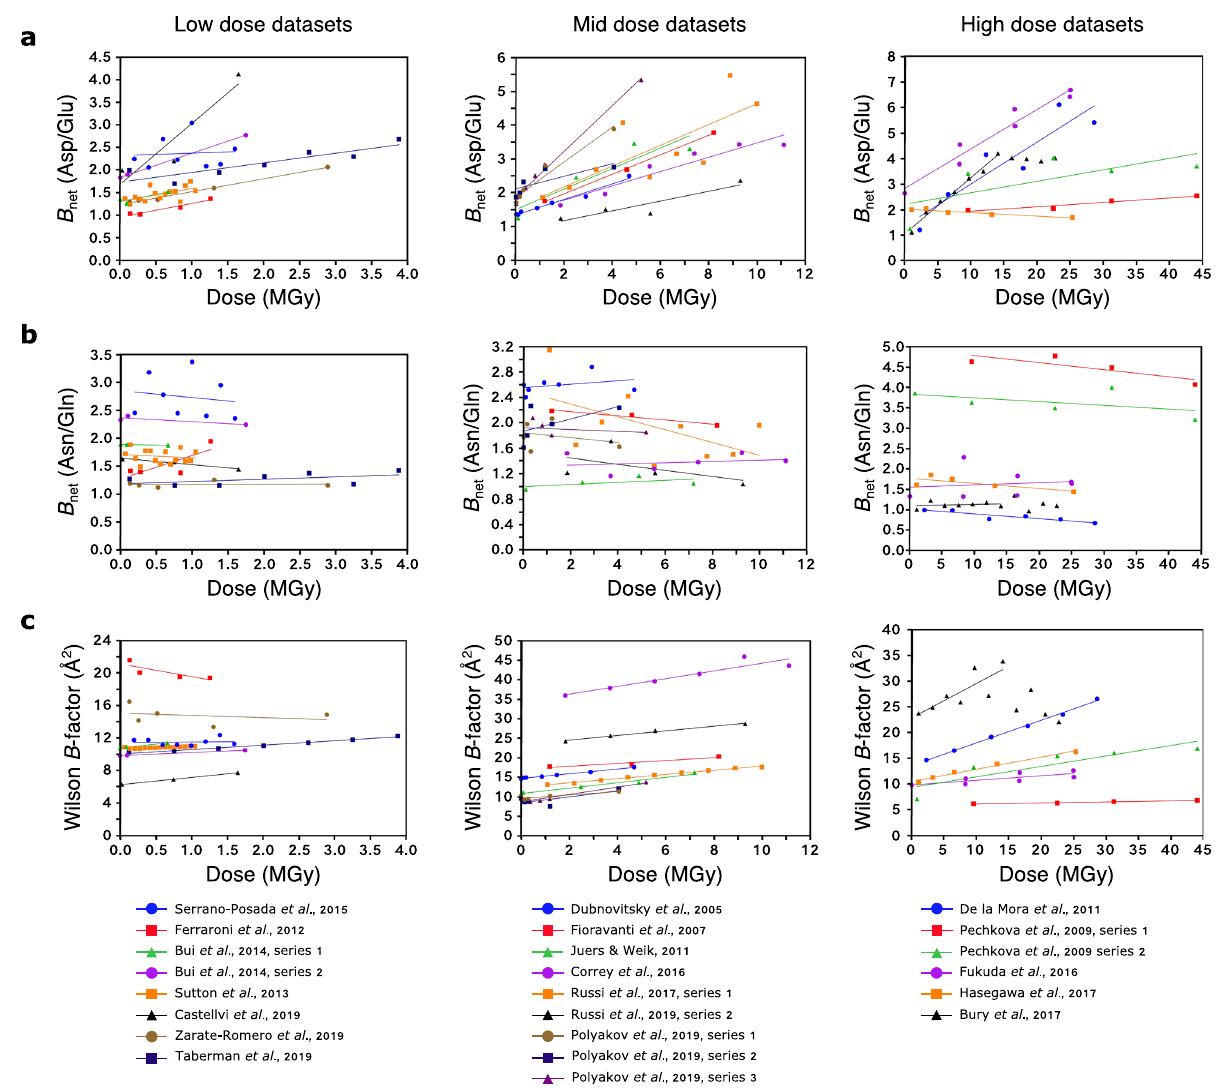
Fig. 3 Dose dependence of the B net metric for radiation damage datasets. a B net (Asp/Glu), b B net (Asn/Gln) and c Wilson B -factor vs. dose for 23 radiation damage datasets. Straight lines of best fi t, calculated via least squares regression, are plotted through each dataset. For clarity, the datasets have been split into “ low ” (0-4 MGy), “ mid ” (4 – 12 MGy) and “ high ” (>12 MGy) groups, determined by the highest dose absorbed. Source data are provided at